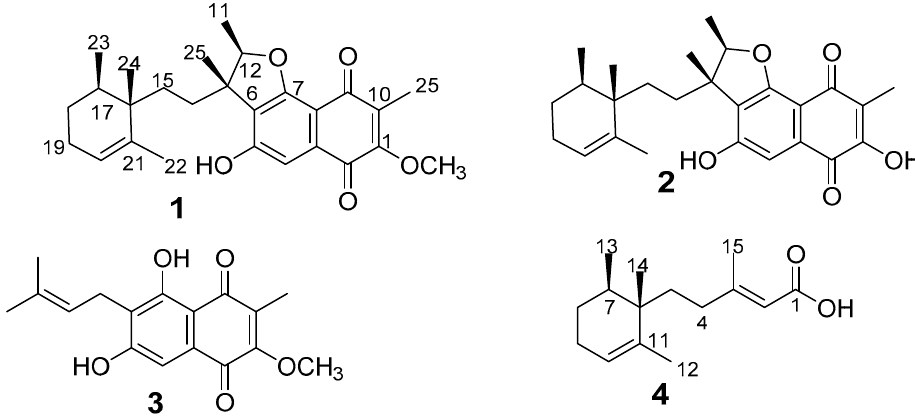
Figure 1. Chemical structures of compounds 1 – 4 isolated from MUCL 56080. Table 1. NMR data for compound 1 and 4 ( 1 H 700 MHz, 13 C 175 MHz, in acetone-d 6 ) and 2 ( 1 H 500 MHz, 13 C 125 MHz, in acetone-d 6 ).